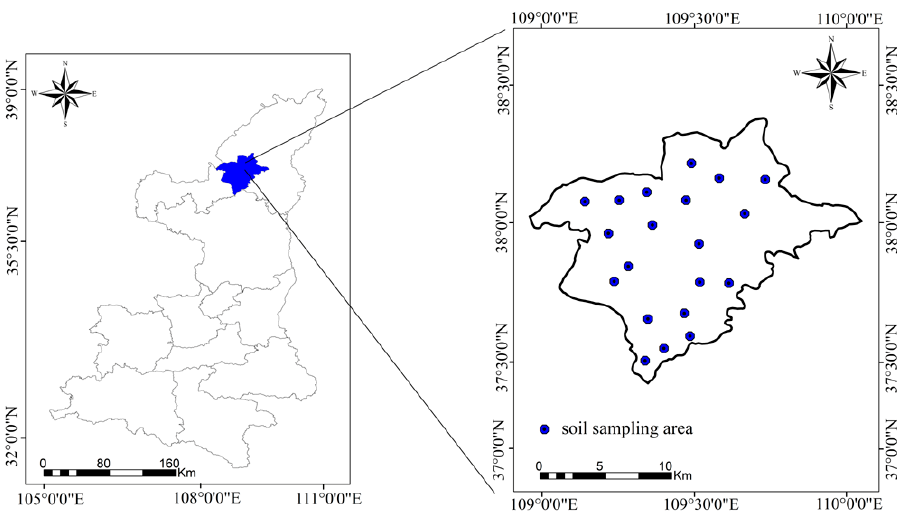
Figure 1. Study region and soil sampling area (the blue dots show the sampling areas).